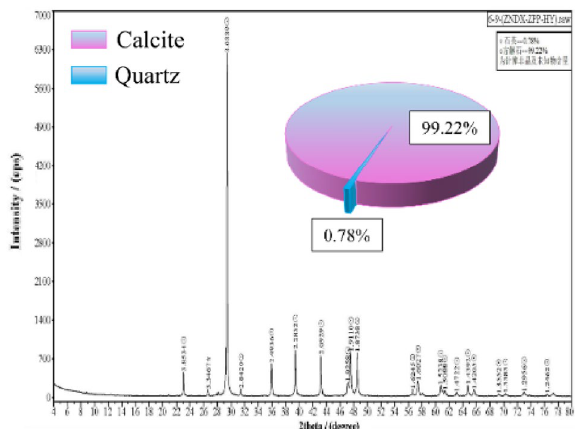
Figure 2. The composition results based on XRD.